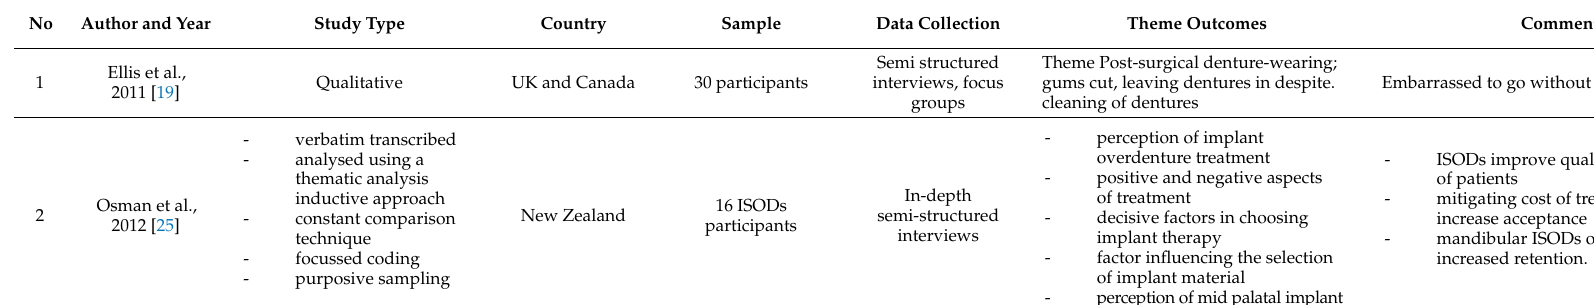
Table A2. Summary of Included